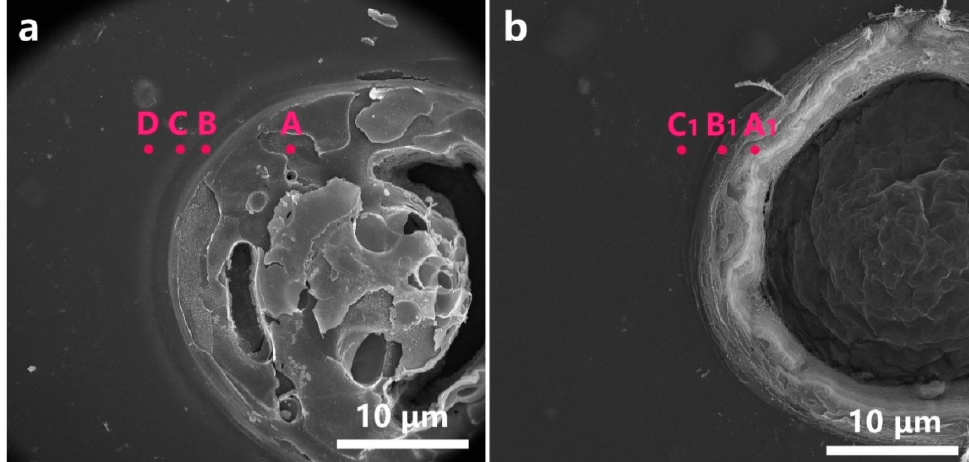
Figure 7. SEM images of the micro-hole ( a ) before cleaning and ( b ) after cleaning. After cleaning, as shown in Figure 7b, the point A 1 on the inner wall of the micro- hole, the point B 1 on the HAZ, and the point C 1 outside the HAZ were selected for Raman and EDS analysis. There are no obvious peaks or carbon peaks on the Raman curve in Figure 8b, indicating that the composition of each position is basically the same after clean- ing. Points A 1 , B 1 , and C 1 have little difference in elemental content (Table 8), further indi- cating that there is no significant difference in the material surrounding the micro-hole after cleaning. Table 8. The atomic percentage in the designated area in Figure 7 before and after cleaning.